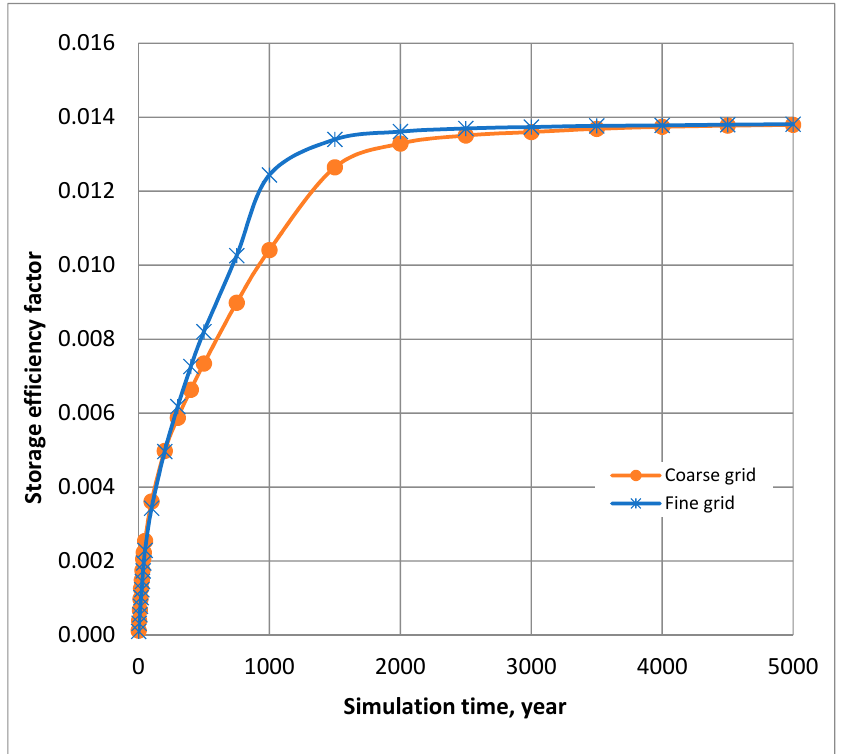
Figure 18. Grid refinement effect on CO 2 storage efficiency in a homogeneous domain. Cases 5 and 6 (Table 4).